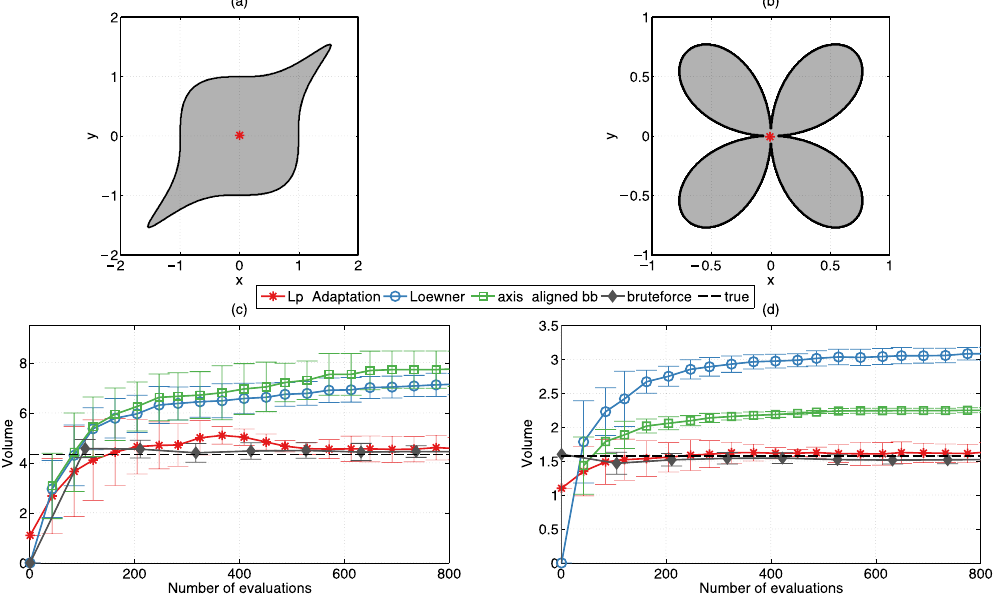
Figure 4. Two 2D test cases from the literature: ( a ) the “Handle” 40 , given by the parametric equation x 6 + y 6 − 1.925 x 3 y 3 ≤ 1, and ( b ) the “Folium” 41 parameterized by − ( x 2 + y 2 ) 3 + 4 x 2 y 2 ≥ 0. Both feasible regions (shaded gray) are non-convex. The red dots are the averaged design centers (of ten individual runs). ( c , d ) Average and standard deviation (over ten independent runs) of the volume estimates obtained with L p - Adaptation (red stars) and brute-force exhaustive sampling (gray diamonds). Upper bounds are obtained from the Loewner ellipsoid (blue circles) and axes-aligned bounding box (green square) of the samples generated by L p -Adaptation. The true volume is indicated by the dashed black line.